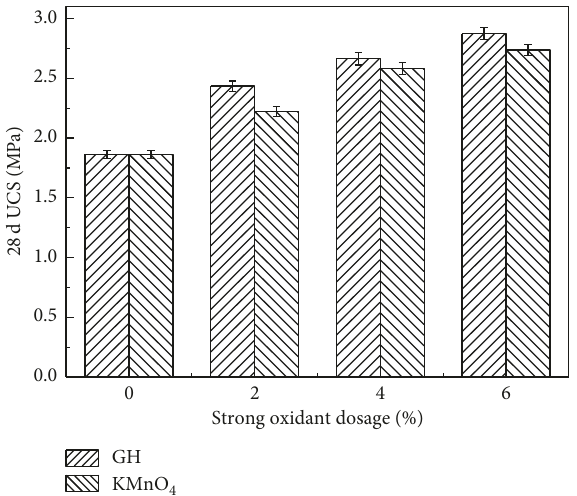
Figure 2: Unconfined compressive strength of samples added with different dosages of strong oxidant (28